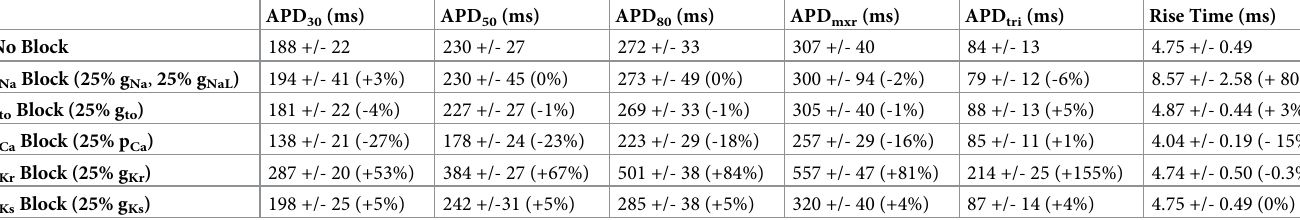
Table 1. AP metric changes under specific ion channel block in computer simulations. Results are reported as mean +/- standard deviation (percent change of mean from cell mean without channel block). 40,000 single cells with channel conductances varied to reflect population-level heterogeneity were paced at 0.5 Hz as described in Methods. AP metrics were determined for the penultimate beat.